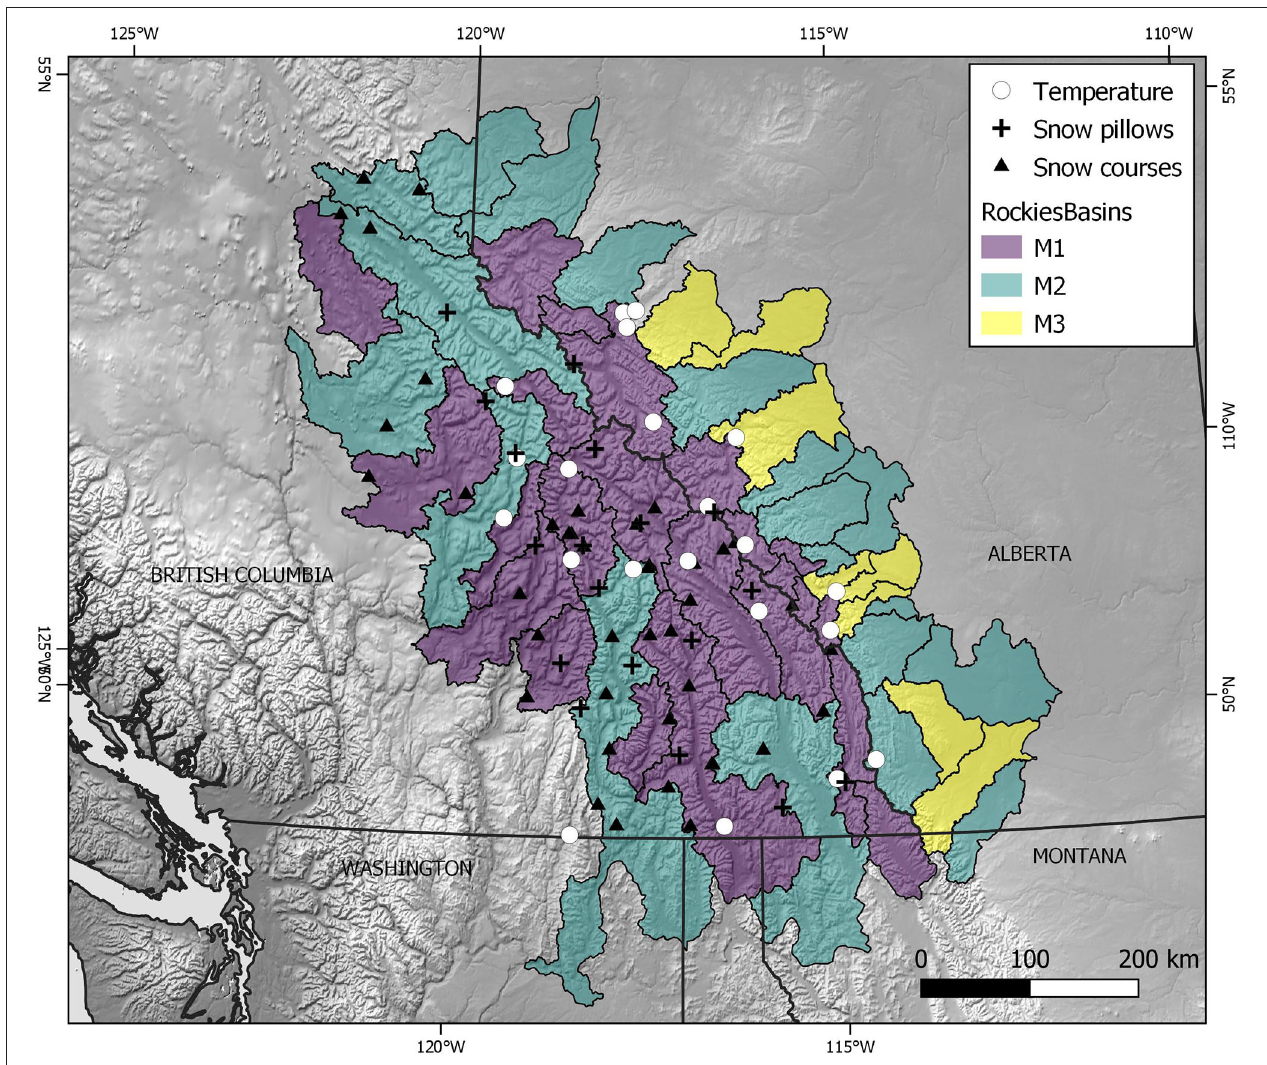
FIGURE 1 | Location of 50 river basins, automated snow pillows, manual snow course sites, and temperature stations from the western Cordillera in southern Canada and northern USA used in this study. Basins are color coded by hypsometry class according to the cluster analysis. here. The calculated Root Mean Squared Error (RMSE) of 309 mm is lower than the interannual standard deviation of 1 Apr SWE at most sites, while the Mean Bias Error (MBE) of + 130 mm reflects an overestimation of SWE. Overall, the linear accumulation model explains 52% of the variance in the observed 1 April